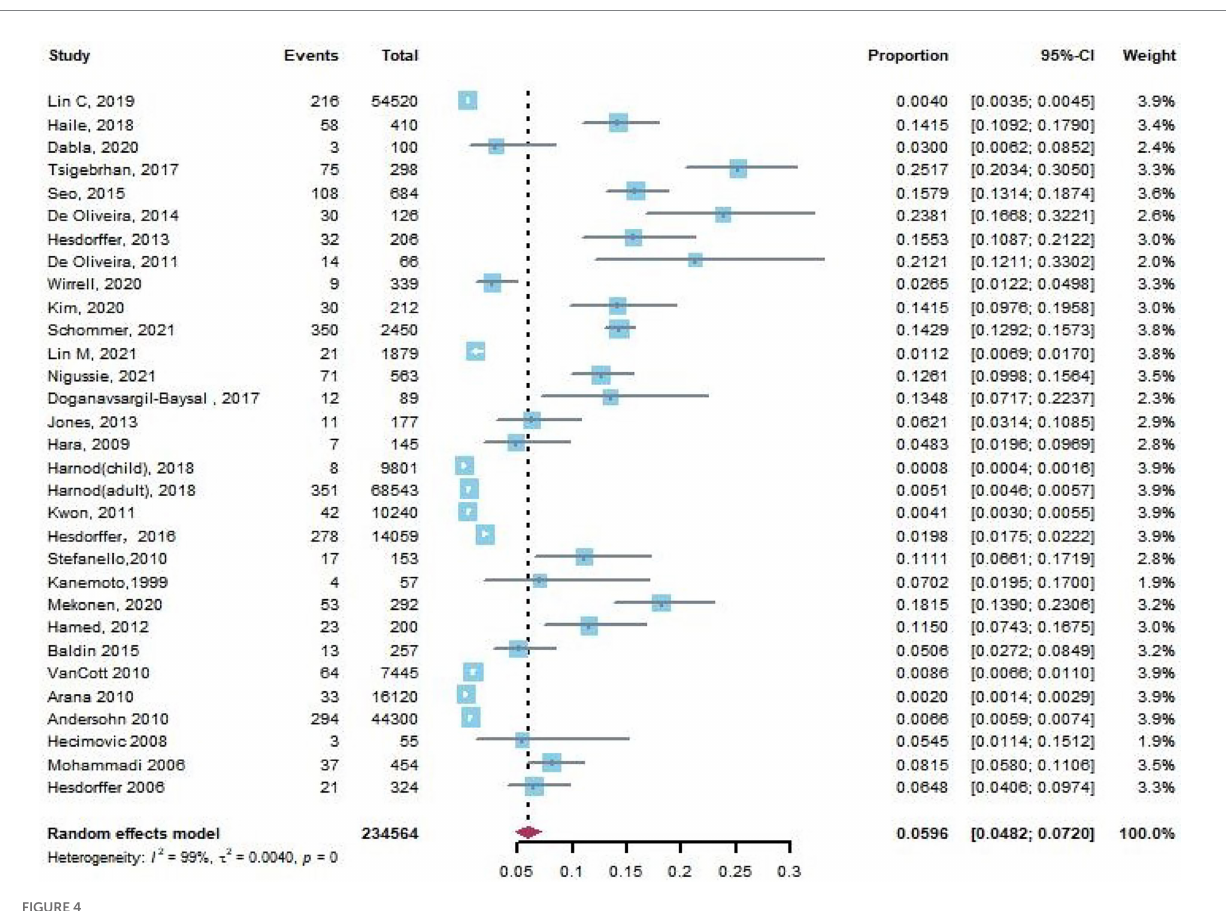
FIGURE 4 The crude rate of suicide attempts in patients with